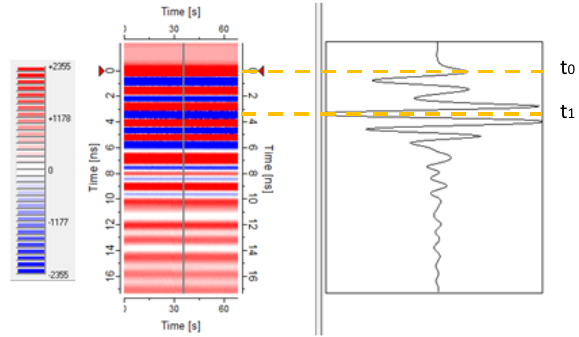
Figure 7. GPR section in the calibration box. Amplitude scale is shown on the left and a specific trace on the right. Upper orange line is time zero (t0), lower orange line is the reflection from the metal bottom (t1).